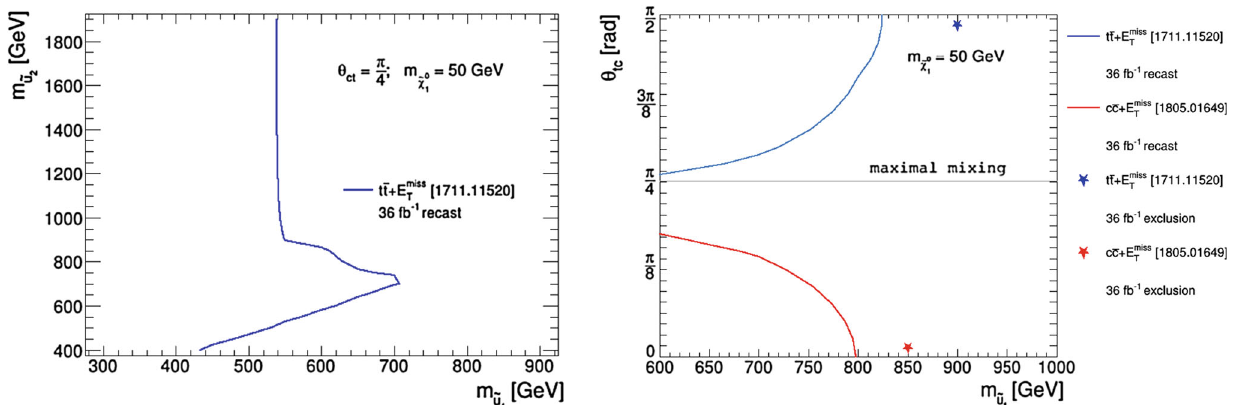
Fig. 2 Reinterpretation, in the context of our simplified model, of the the stars correspond to the official ATLAS results in the non-flavour- ATLASboundsontopsquarksobtainedwithsingle-leptonicprobes[12] mixing case. The excluded region lies between the exclusion contour andonSupersymmetrywhencharmtaggingisused[15].Theresultsare and the left-side of the , m ˜ ) plane (left) and ( m ˜ ,θ ) plane (right), and presented in the ( m ˜ u tc u 2 u 1 1